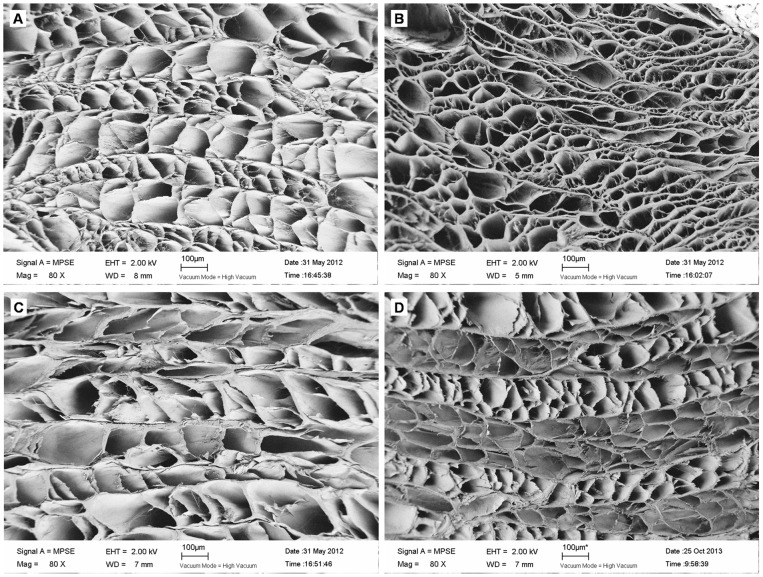
Scanning electron micrographs of cross-sections of AF samples.(A) Triton X-100, (B) SDS, (C) trypsin, (D) control.